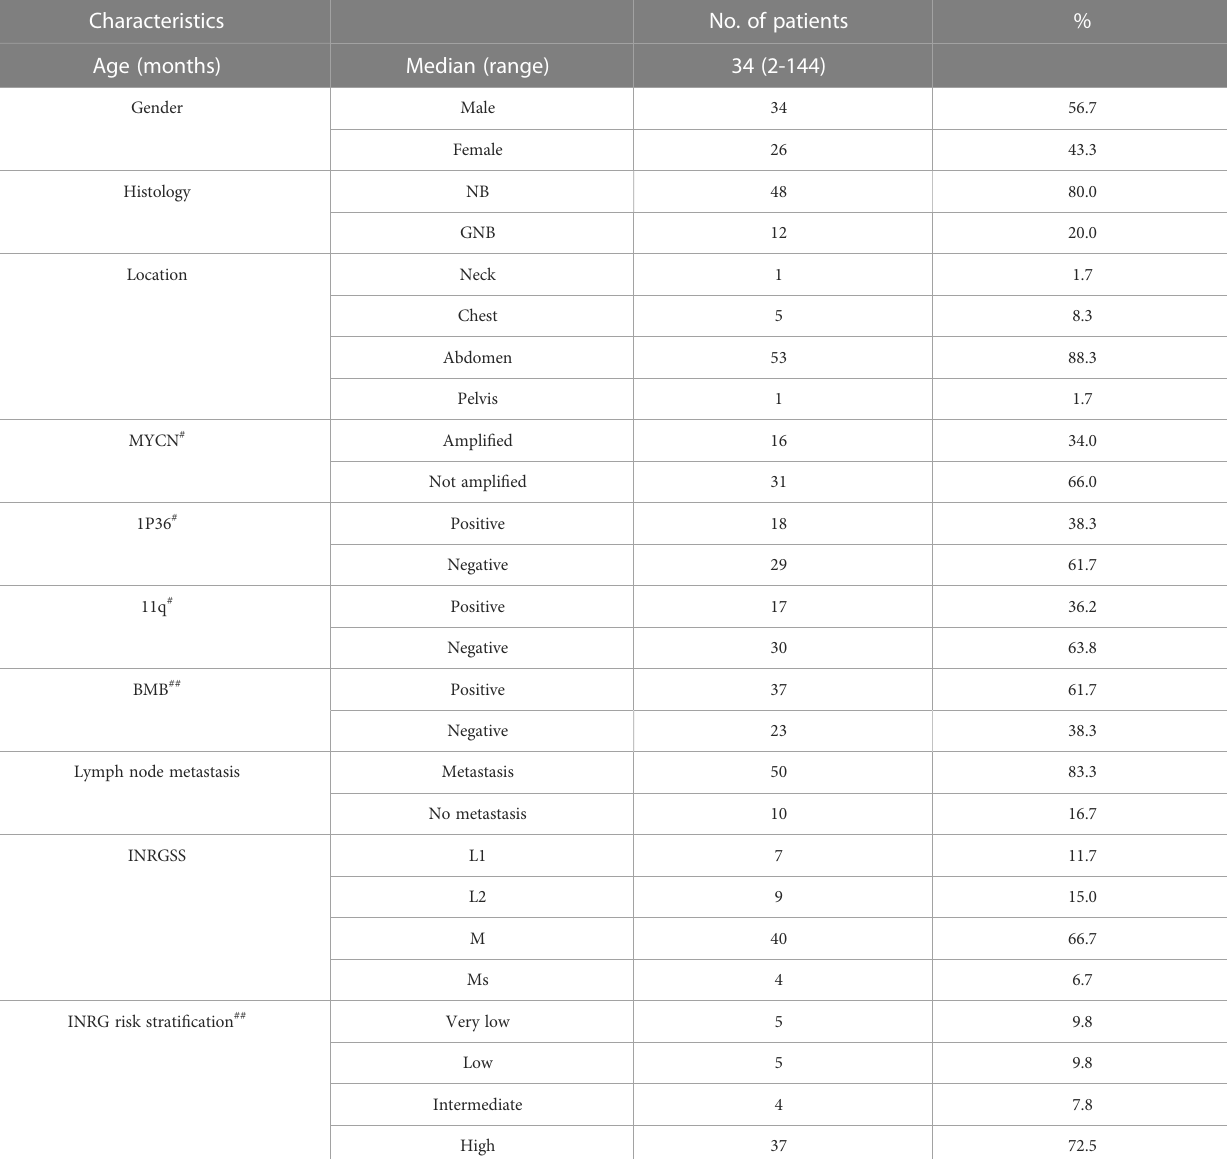
TABLE 1 General characteristics of 60 patients.